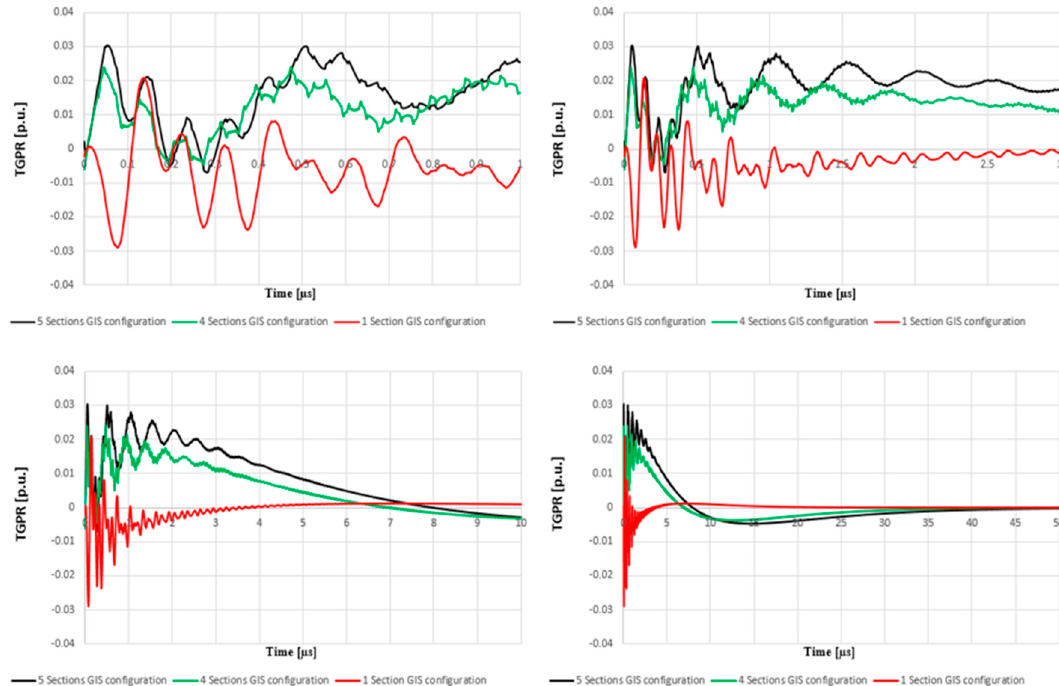
Figure 11. Transient ground potential rise across copper strip located on GIS platform, considering ff erent GIS buses’ different GIS buses’ configuration. di